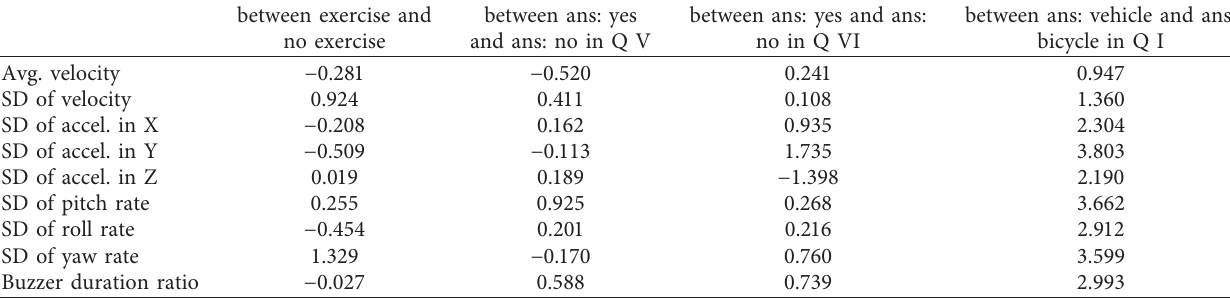
Table 9: t -test results for effects of human factors in scenario 2 (avg.: average, SD: standard deviation, accel.: acceleration, ans: answer, Q: question). between exercise and no exercise between female and male